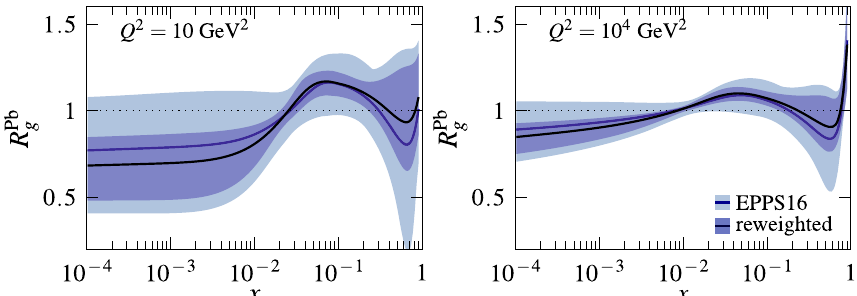
sented at the parametrization scale Q 2 = 1 . 69 GeV 2 . For better visi- bility, the s -quark modifications are presented with a different vertical axis scaling